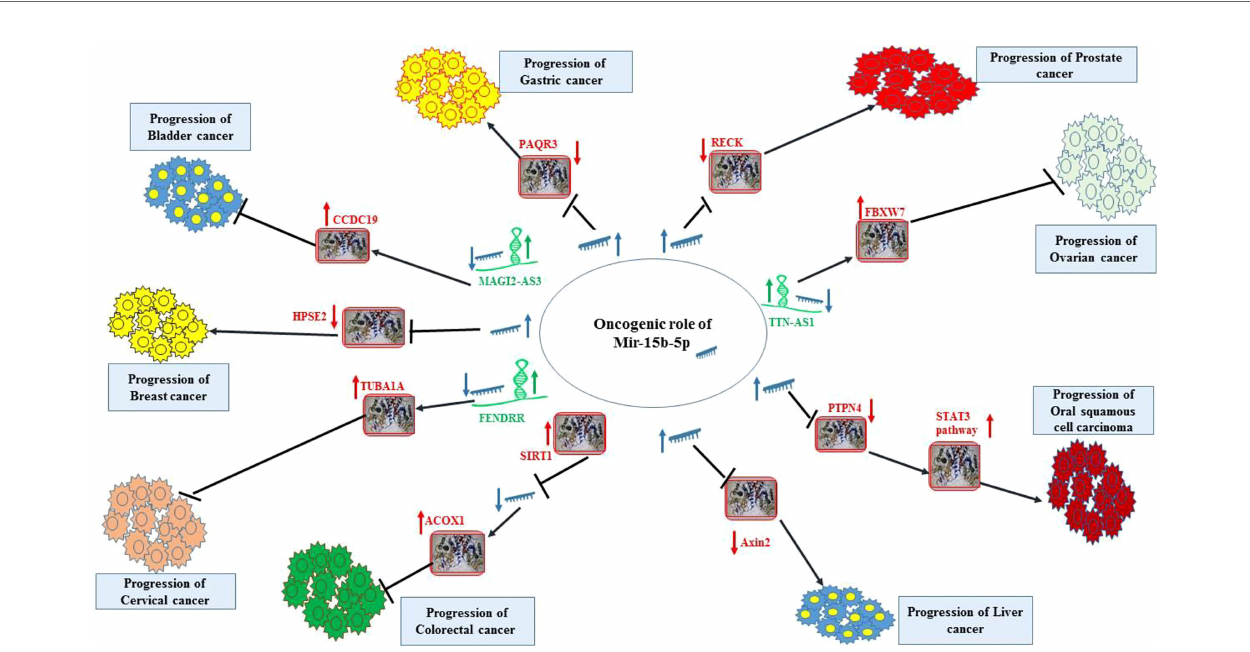
FIGURE 1 | Oncogenic effect of miR-15b-5p in bladder, breast, cervical, colorectal, liver, oral, ovarian, prostate and gastric cancers. Detailed information about the conducted experiments is shown in Table 1